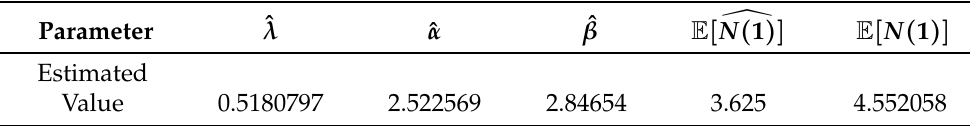
Table 1. Hawkes Estimated Parameters and their Empirical and Theoretical Estimated Number of Arrivals of Group 1.